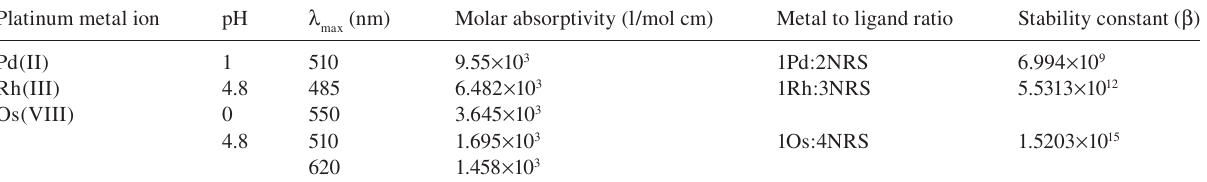
Table 1 Characterization of some platinum metal ions – NRS complexes in aqueous solutions. Platinum metal